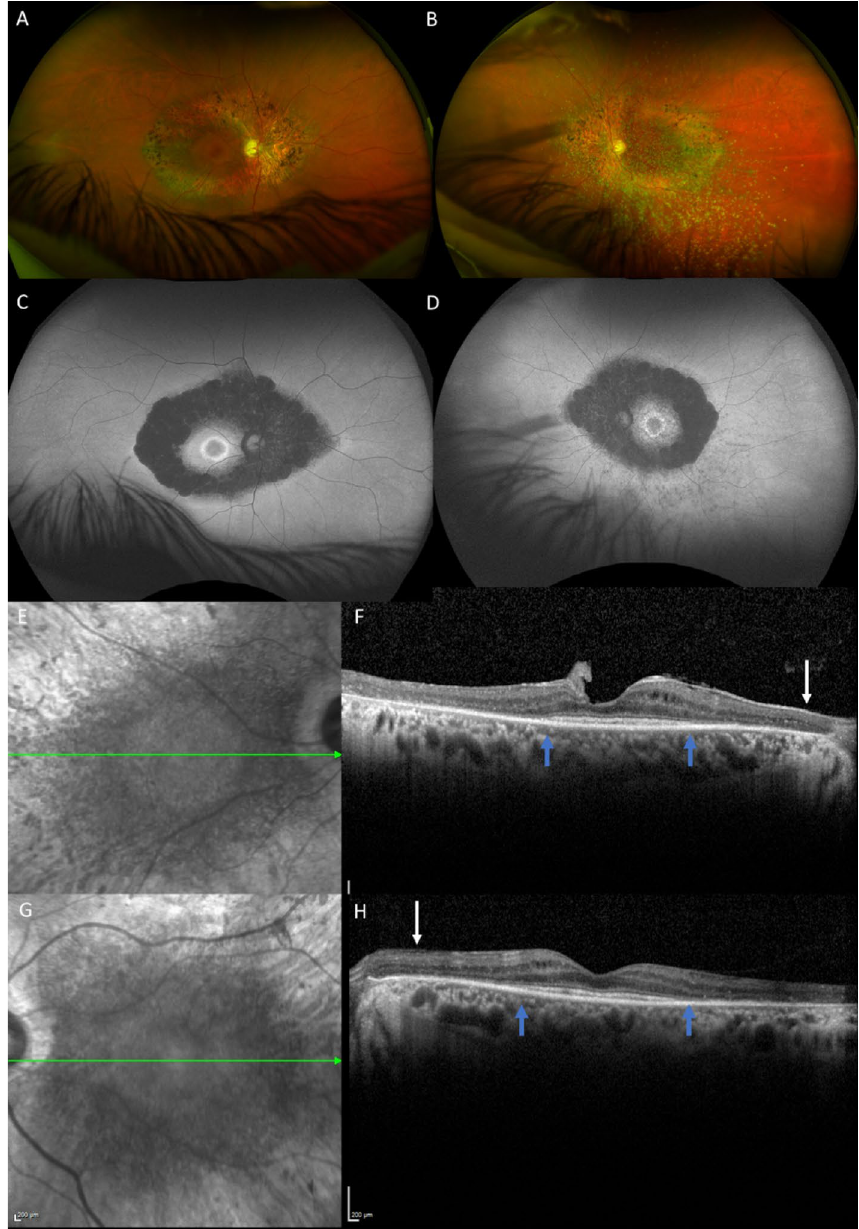
Figure 5. DOA plus rod-cone dystrophy in the individual V-42. This 69 year-old-patient was legally blind with a visual acuity of 20/400 in both eyes. Visual loss occurred at the age of 6 years. ( A , B ) Color fundus photographs. Note the temporal pallor and criteria of combined rod cone dystrophy with attenuated retinal vessels and typical pigmentary changes along the vascular arcades. ( C , D ) FAF showing patches of hypoautofluorescence more prominent and confluent around the vascular arcades, and an autofluorescence perifoveal ring. ( E – H ) Infrared reflectance photographs and macular SD-OCT. There is a severe thinning of the papillomacular bundle (white arrows) compatible with the optic atrophy. The outer nuclear layer EZ and IZ lines are not visible outside the macula (blue arrows) in both eyes due to the rod-cone dystrophy. Photographs were taken by